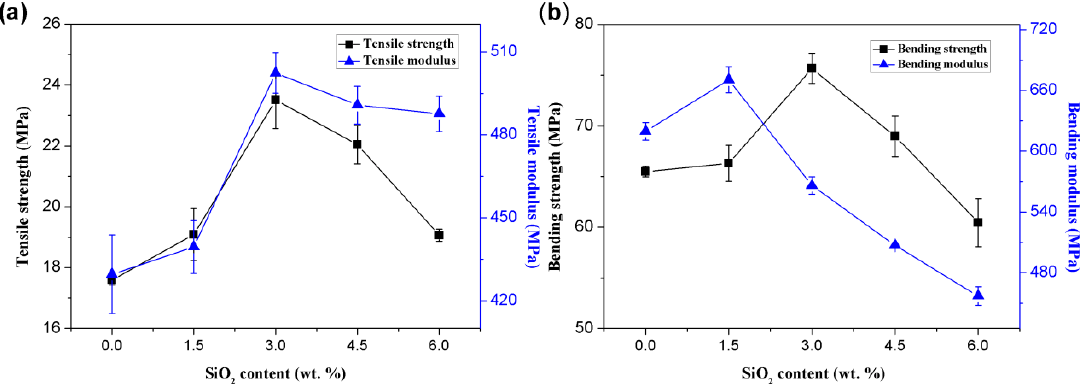
Figure 4. The mechanical properties of RHNS/PHBV composites: ( a ) tensile strength and tensile modulus and ( b ) bending strength and flexural modulus.